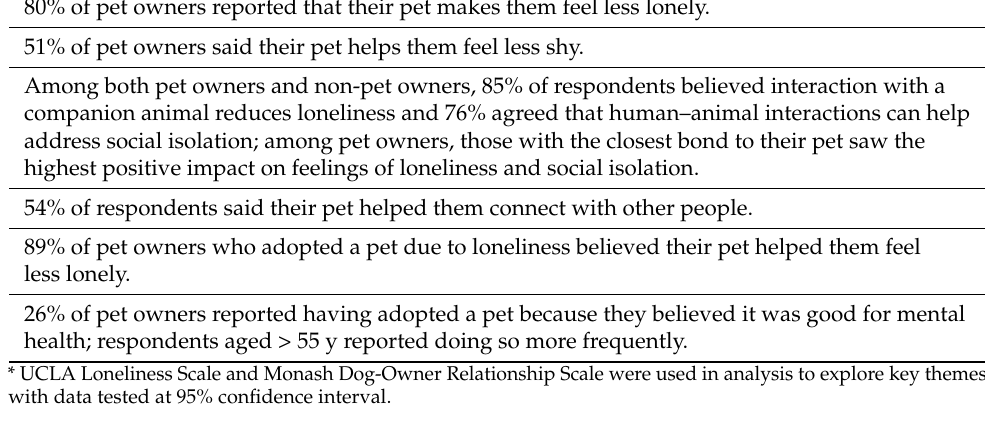
Table 1. Findings of a market research study on the impact of companion animals on social isolation and loneliness among 2036 US respondents, including 1469 pet owners (72%) [47] *. 80% of pet owners reported that their pet makes them feel less